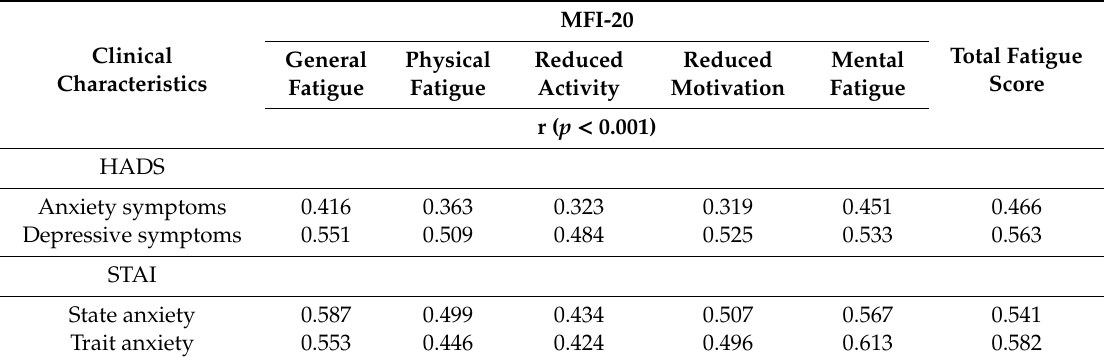
Table 3. Convergent Validity: Pearson Correlation Coe ffi cients between the MFI-20, the HADS, the STAI, the SF-36, and EC testing in overall